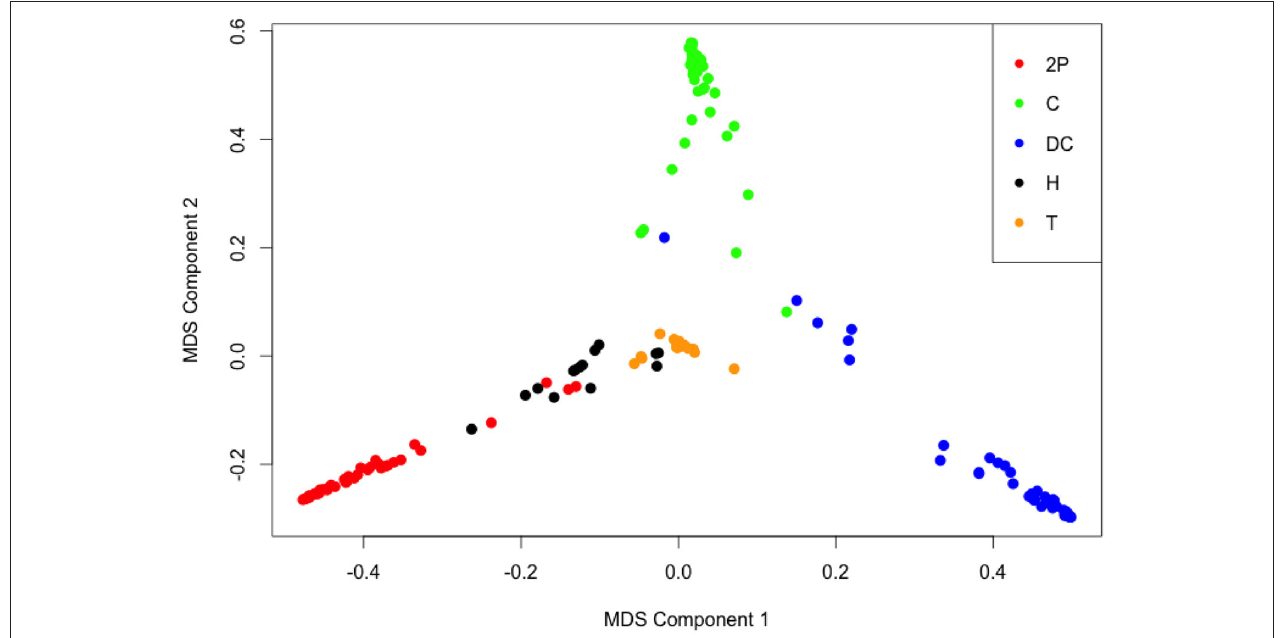
FIGURE 3 | Multi-dimensional scaling (MDS) of the proximity matrix showing Mecopoda song type clusters based on log transformed standardized cuticular lipid peak areas of 166 Mecopoda individuals. The different colored circles represent Mecopoda song types: 2P, Two Part; C, Chirper; DC, Double Chirper; H, Helicopter; T, Train.